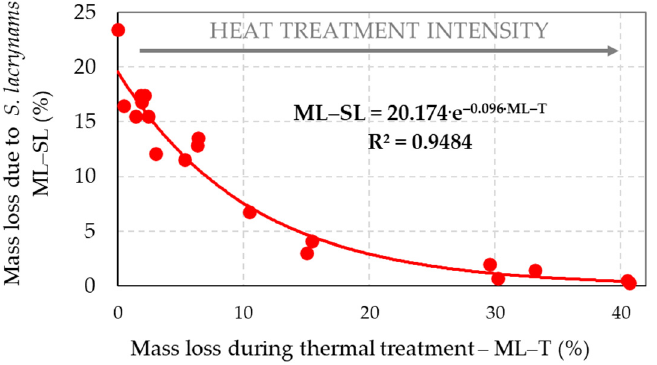
Figure 2. Correlation between the mass loss of wood resulting from its individual thermal treatments (ML–T) and the mass loss of wood caused by decaying fungi at 8-week mycological test by fungus brown-rot S. lacrymans (ML–SL).